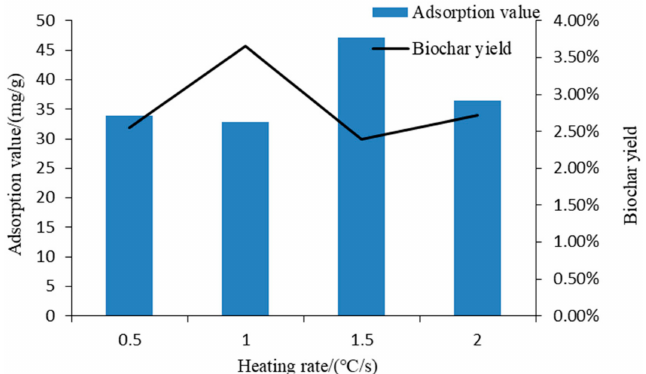
Figure 4. E ff ect of heating rate on the biochar yield and